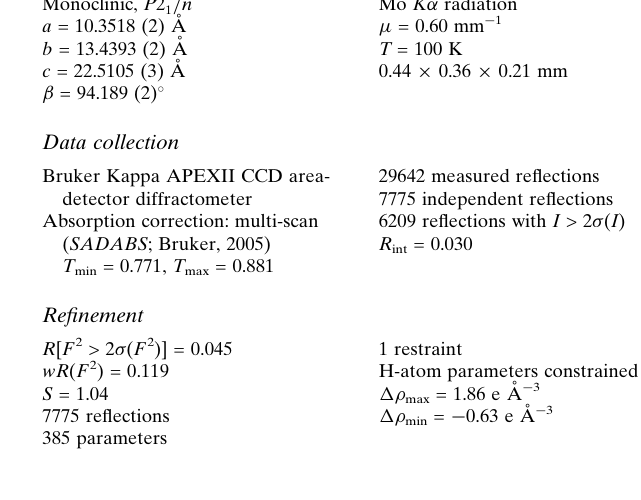
Bruker Kappa APEXII CCD area- detector diffractometer